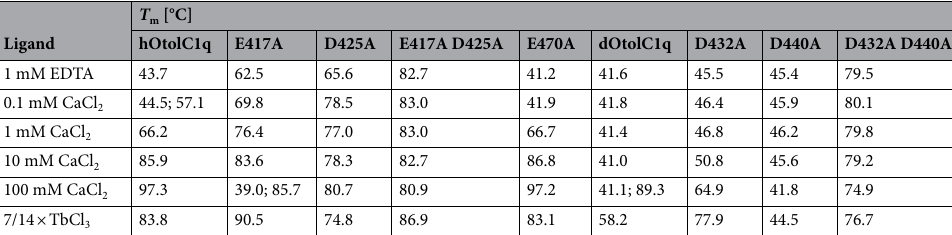
Table 2. Thermal stability of hOtolC1q, dOtolC1q and their mutants in the presence of Ca 2+ and Tb 3+ . The transition temperatures ( T m ) of hOtolC1q, dOtolC1q and their mutants in the presence of 1 mM EDTA, 0.1– 100 mM CaCl increasing temperature (dF/dT).